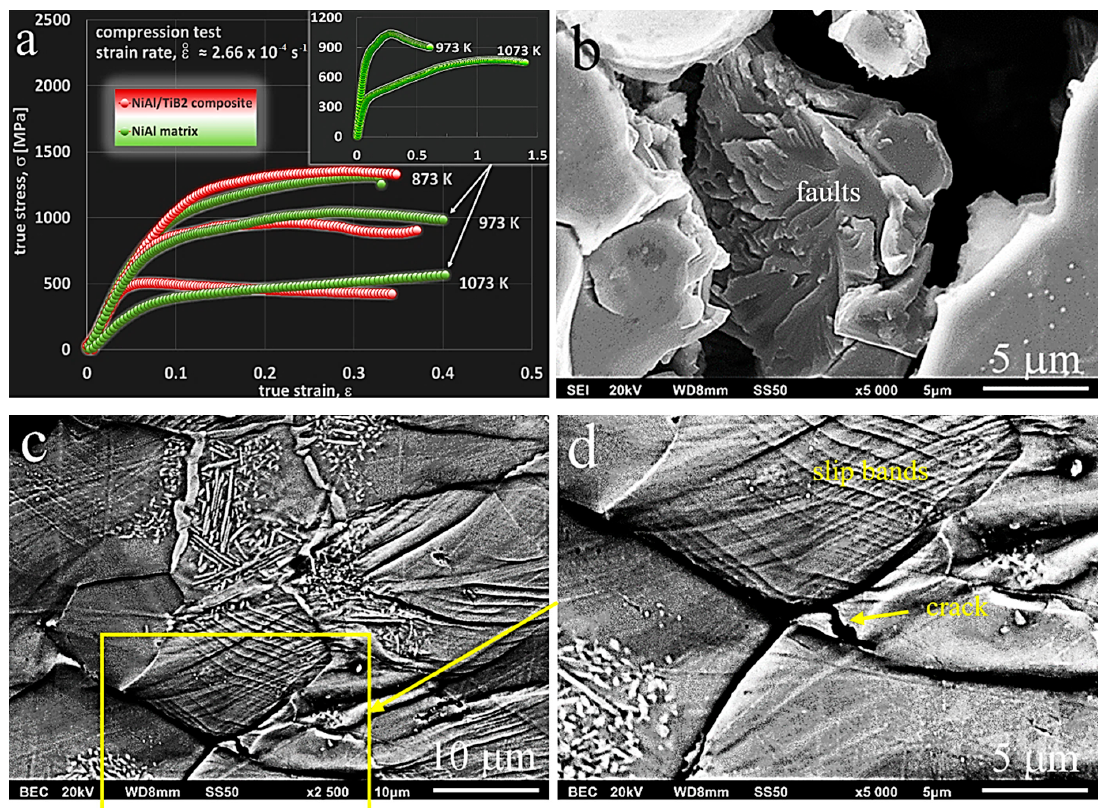
Figure 9. High-temperature compression test: ( a ) course of curves at specific temperatures of NiAl matrix and composite with additions of TiB 2 ; matrix microstructure ( b ) after deformation at a temperature of 873 K, ( c ) at a strain level of 0.3, ( d ) cracks at grain boundary.